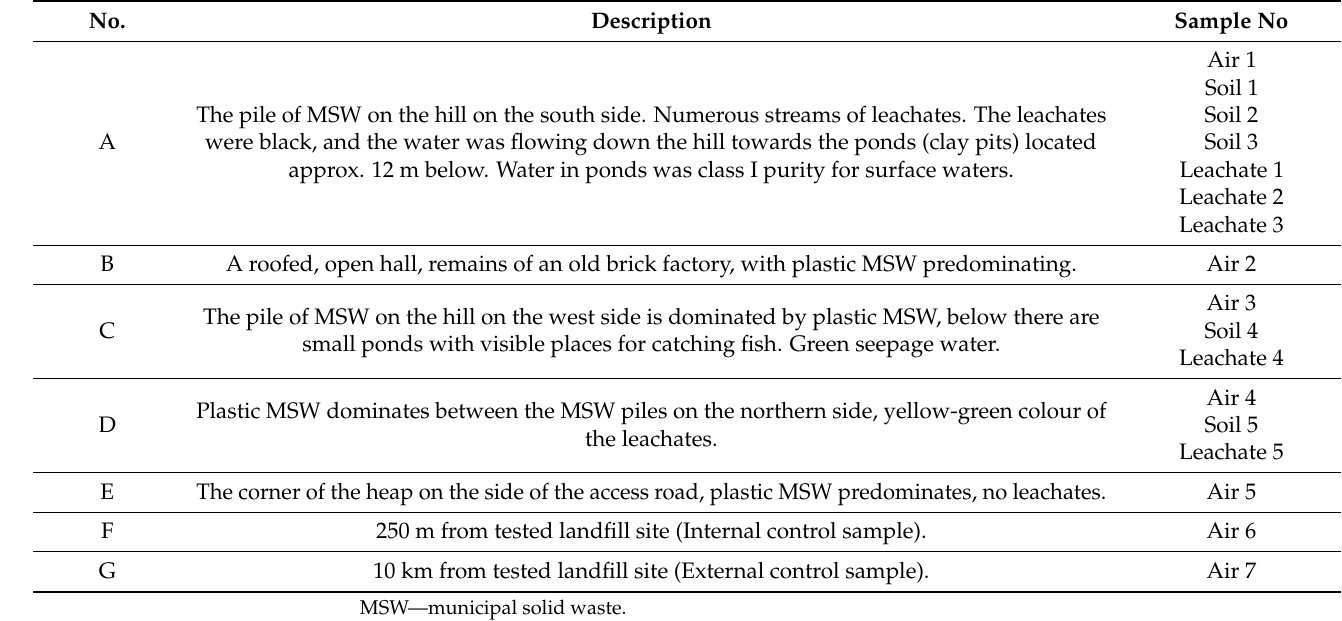
Table 1. Characteristics of sampling sites in an illegal